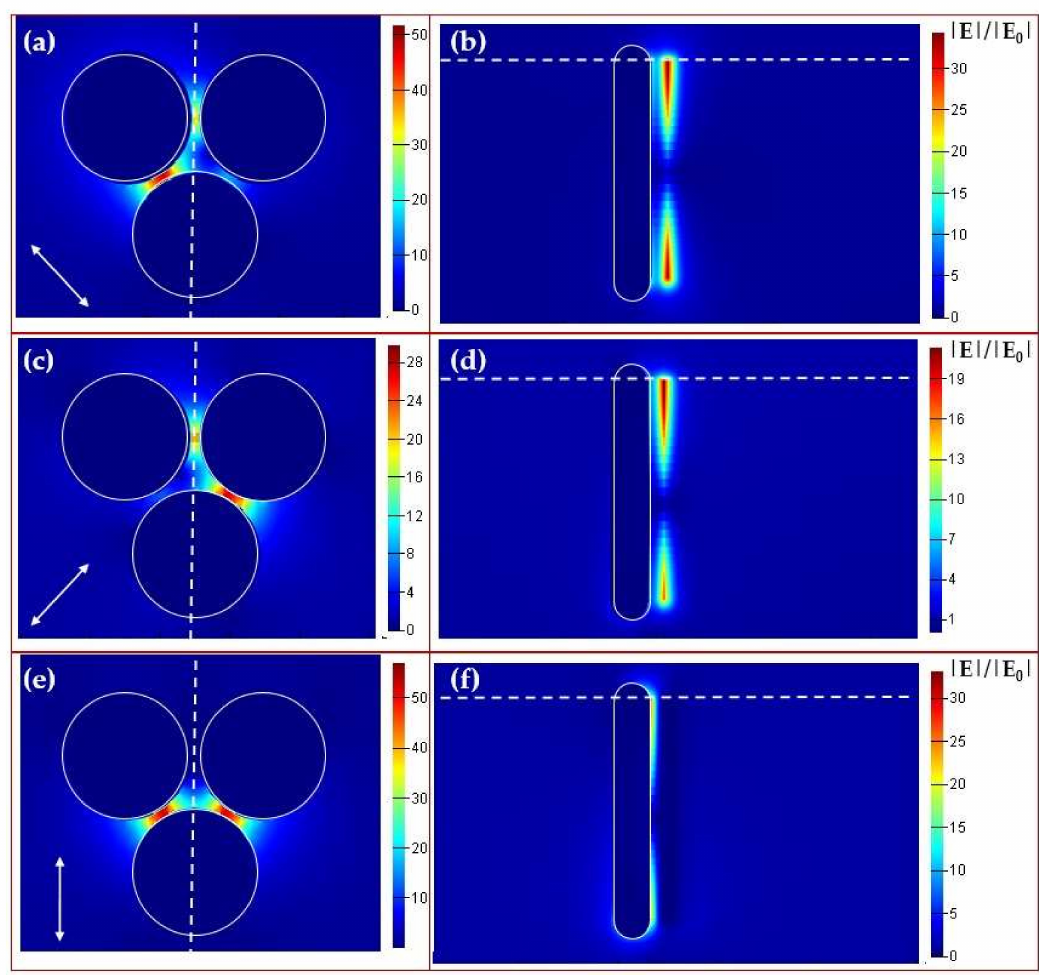
Figure 8. Spatial distributions of the electric field amplitude for radial ( a , b ), azimuthal ( c , d ) and linear ( e , f ) polarization and λ = 2100 nm inside the nanorod trimer. ( a , c , e ) Top view in the cross-section plane shown by the white dashed line in ( b , d , f ). The white arrow shows the local polarization direction. ( b , d , f ) Side view in the cross-section plane shown by the white dashed line in ( a , c , e ). Electric field localization between nanorods can be observed. The color scale is given for the normalized magnitude |E|/|E 0 |. The electric field distribution in ( a ) is asymmetrical because of the location of the trimer in the bottom-right sector of the Laguerre–Gaussian beam with radial polarization. The trimer is not exactly symmetrical in relation to the polarization vector in this